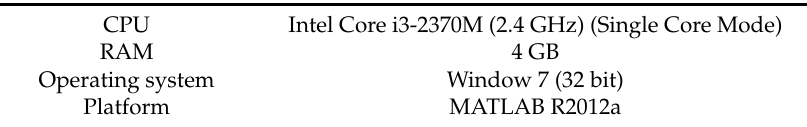
Table 4. Computing environment.